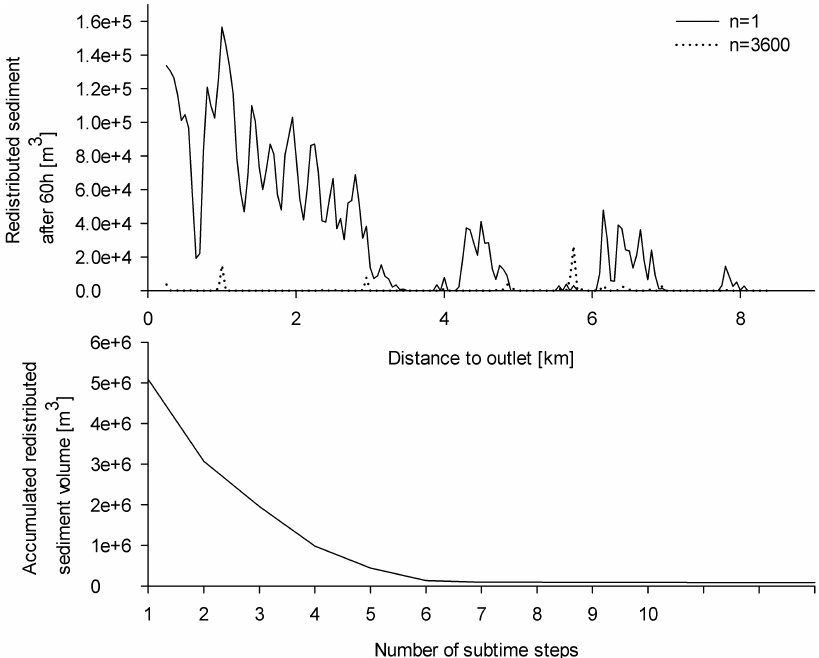
Fig. 10. Effect of sub-time step modelling. A : Artificially redistributed sediment along the channel; B : accumulated, redistributed sediment volumes simulated with different temporal